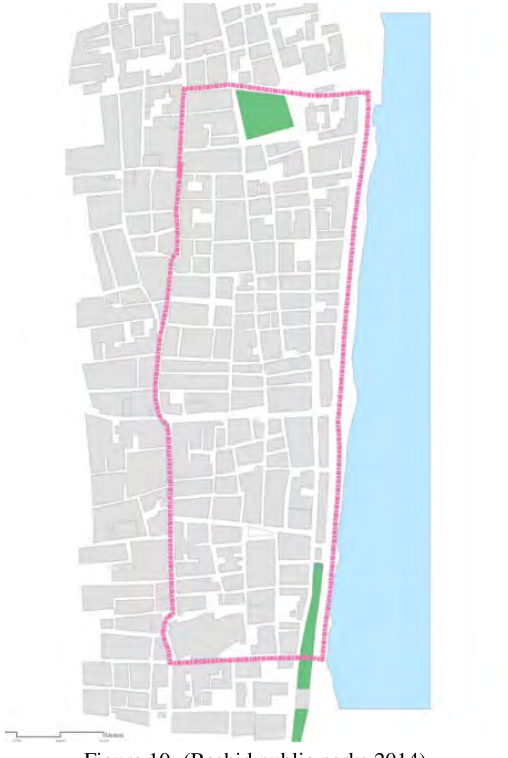
Figure 10. (Rashid public parks 2014)